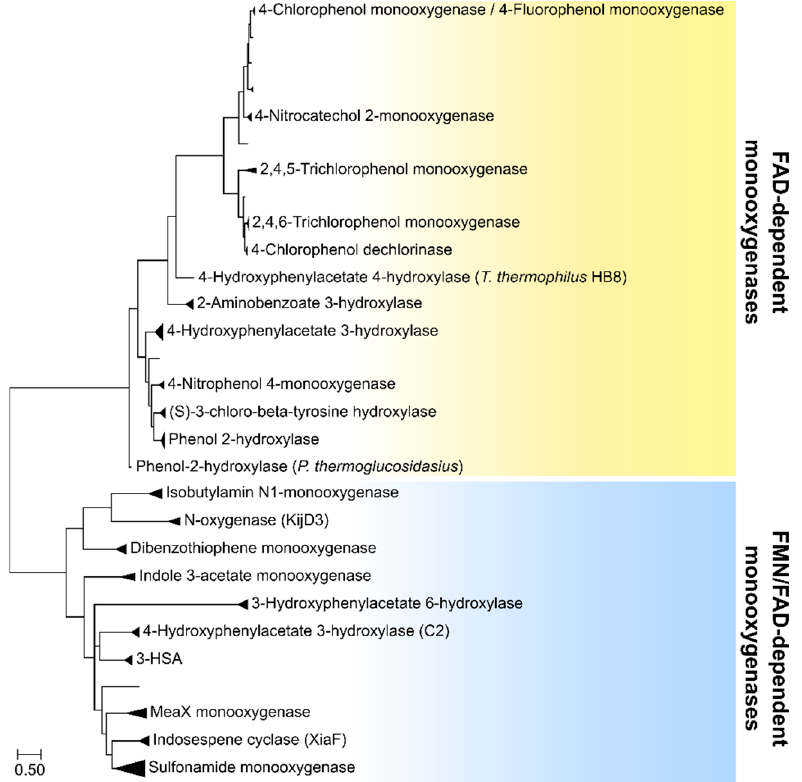
Figure 2. Condensed phylogenetic distance tree of group D monooxygenases. Group D enzymes can be distinguished into FAD and FAD/FMN-dependent clades. Amino acid sequences were aligned by using the ClustalW algorithm and after phylogenetic analysis, the maximum likelihood tree was constructed applying the MEGA7 software with bootstraps of 1000 replicates [50]. Table 1. Representatives of Group D.